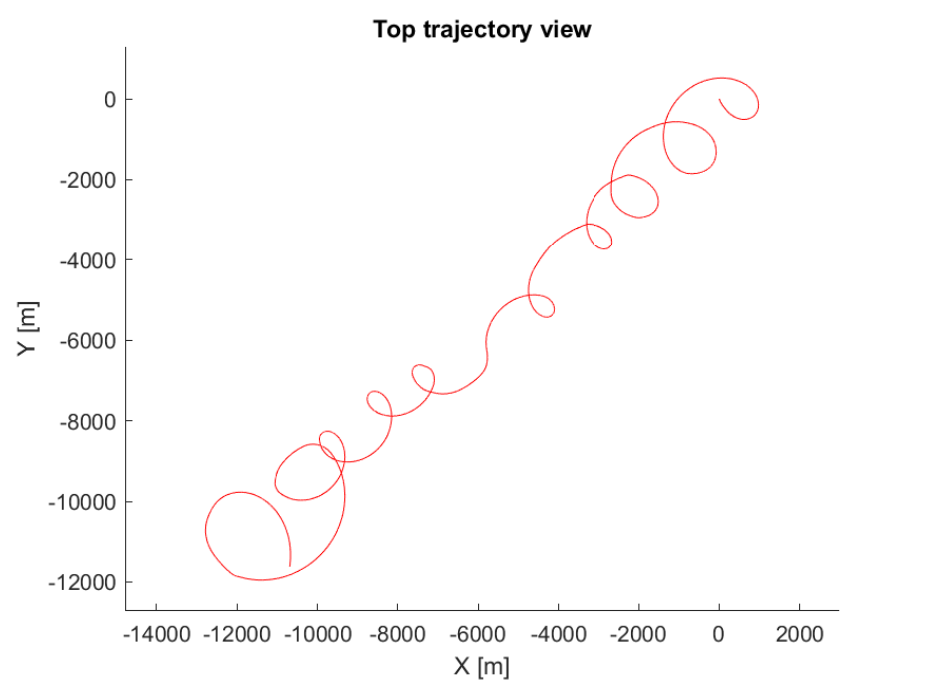
Figure 6. Flight trajectory top